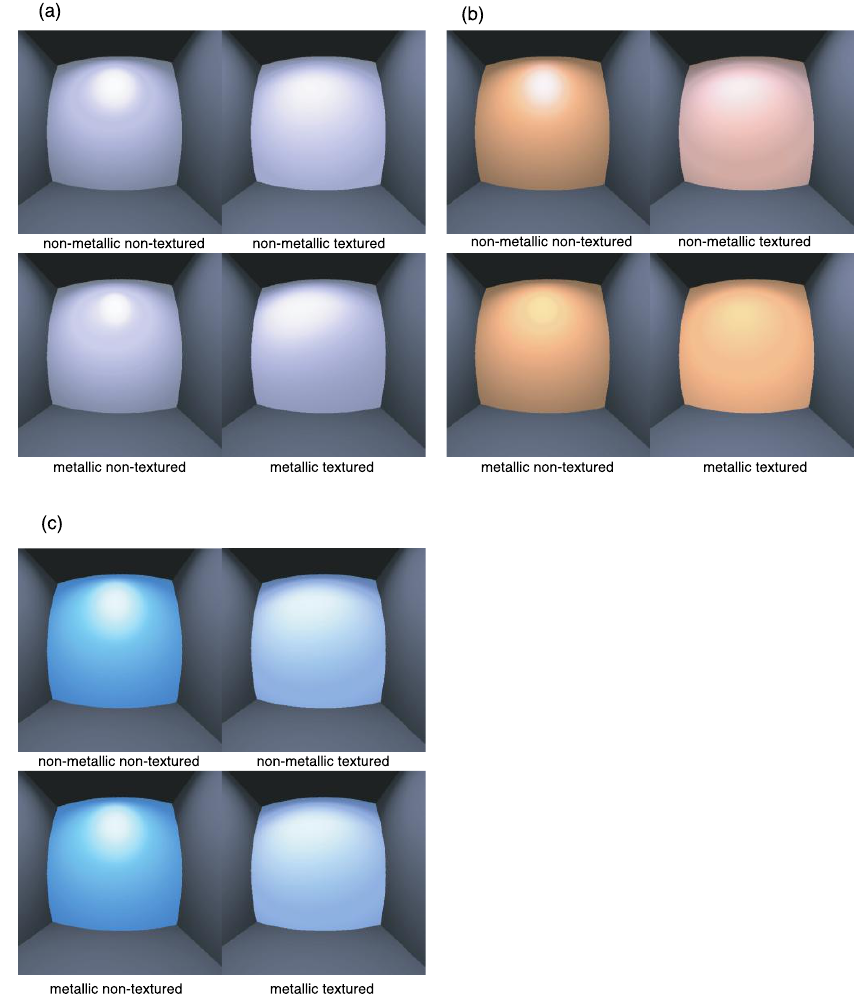
Figure 3. Images of the active wall with different material types, spectral reflectances, and texture, rendered with the RADIANCE software.